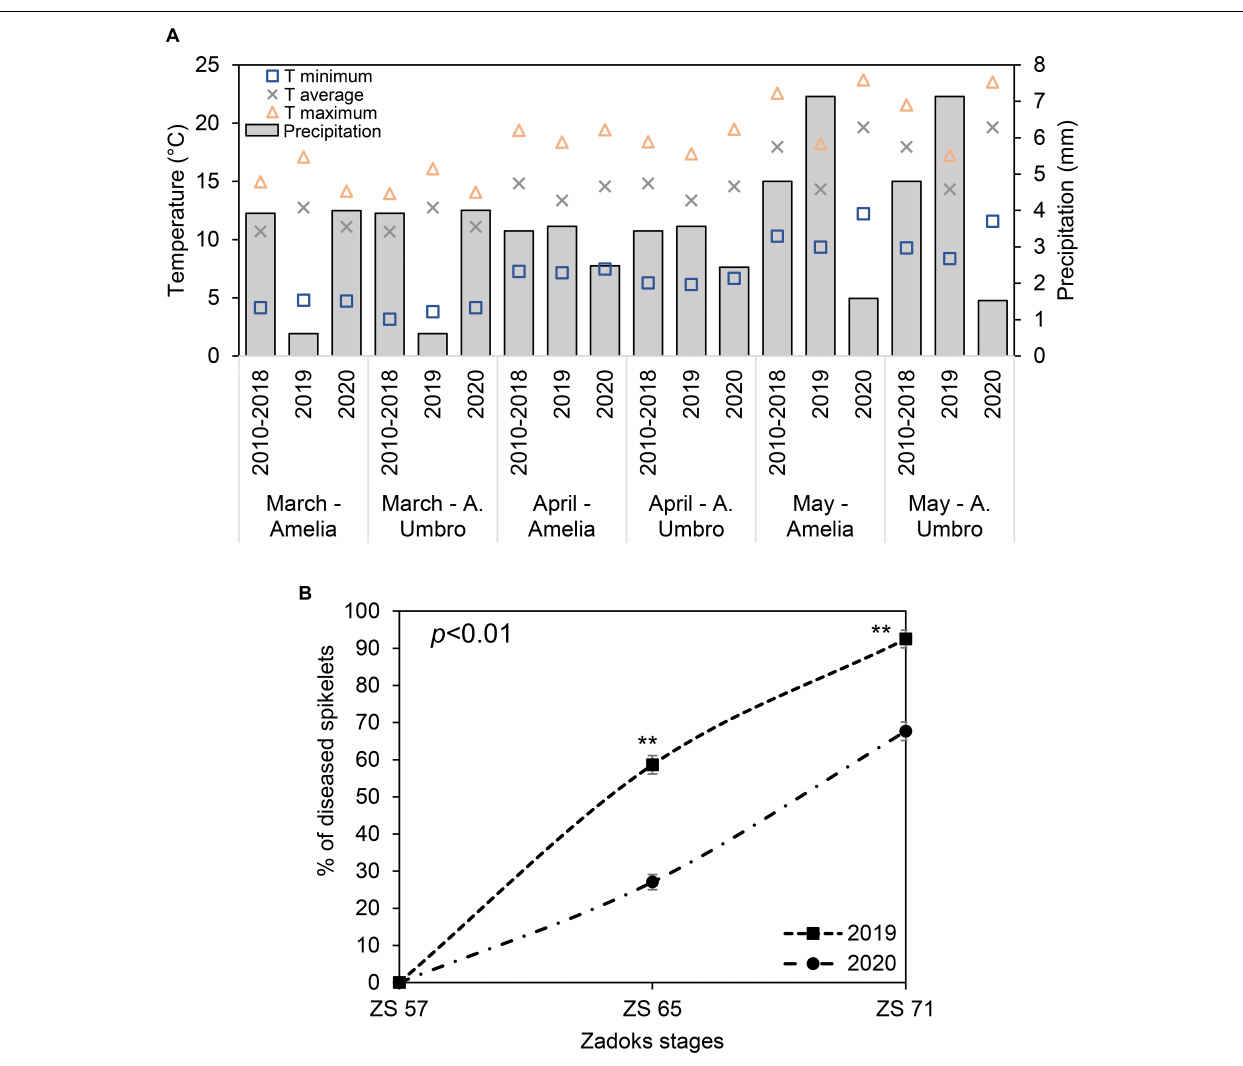
FIGURE 2 | (A) Changes in maximum (yellow triangles), average (grey crosses) and minimum (blue squares) temperature (T), and precipitation (simple bar) of weather data recorded in 2019 in comparison with weather data recorded in 2020 and historical weather data from 2010 to 2018 for March, April, and May. The plotted values were obtained by averaging the mean daily values for each considered period. Weather data for 2019 and 2020 were recorded daily by two meteorological stations installed at 100 m distance from each of the experimental fields located in Amelia (Central Italy, 42 ◦ 31 (cid:48) 22.9 (cid:48)(cid:48) N, 12 ◦ 25 (cid:48) 15.5 (cid:48)(cid:48) E, Umbria Region) and Avigliano Umbro (Central Italy, 42 ◦ 40 (cid:48) 41.1 (cid:48)(cid:48) N, 12 ◦ 27 (cid:48) 44.6 (cid:48)(cid:48) E, Umbria Region). Historical weather data (2010–2018) were collected from the Hydrographic service of Umbria Region (https://annali.regione.umbria.it/). The historical weather data were collected from two meteorological stations located in Amelia (42 ◦ 33 (cid:48) 25.0 (cid:48)(cid:48) N, 12 ◦ 25 (cid:48) 01.0 (cid:48)(cid:48) E) and Avigliano Umbro (42 ◦ 40 (cid:48) 39.0 (cid:48)(cid:48) N, 12 ◦ 26 (cid:48) 13.0 (cid:48)(cid:48) E). (B) Severity percentage of Fusarium head blight (FHB) in Triticum turgidum (cv. Marco Aurelio) at Zadoks stage (ZS) 57, 65, and 71 in 2019 and 2020. Data represent averages and standard errors of 256 spikes (16 spikes for each of 16 visible targets). Asterisks (**) refer to the statistical analyses performed using one-way analysis of variance (ANOVA) with Tukey’s honest significant difference (HSD) post hoc test at 0.99 confidence level and p <